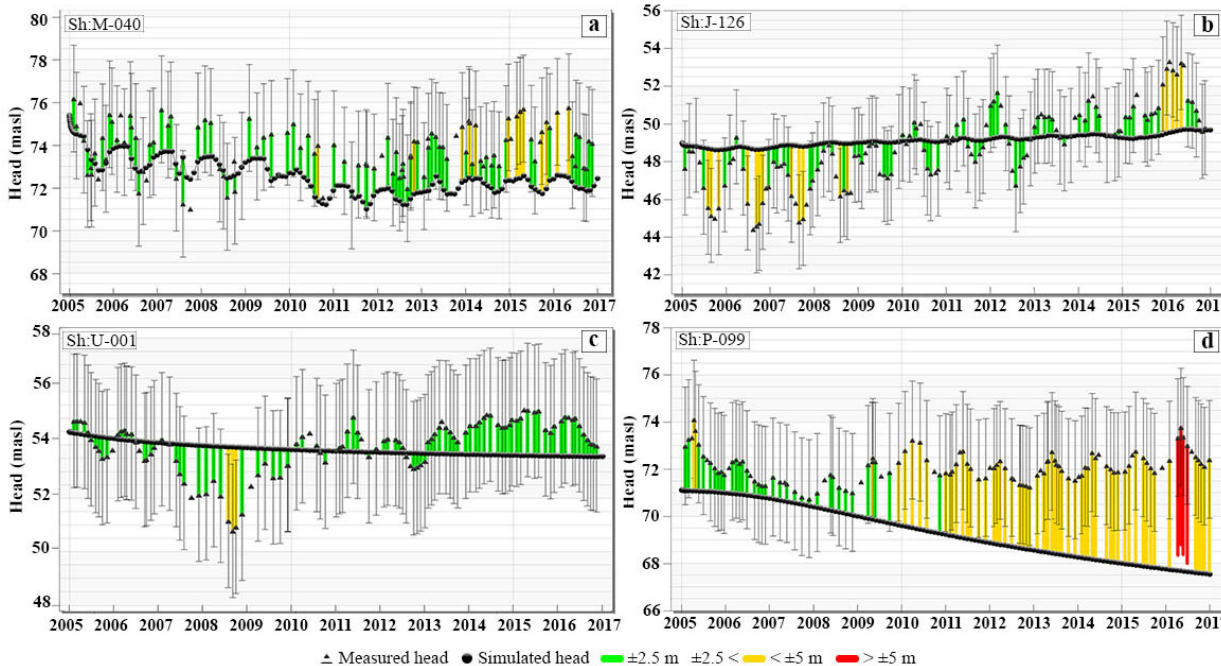
Figure 12. Hydrographs comparing simulated and observed head against the ±2.5-m target at monitoring wells screened in the Memphis, shallow, and Fort Pillow aquifers (See Figure 10). ( a ) Well Sh:M-040. ( b ) Well Sh:J-126. ( c ) Sh:U-001. ( d ) Sh:P-099. The colored bar indicates the level of modeled error against measured values.